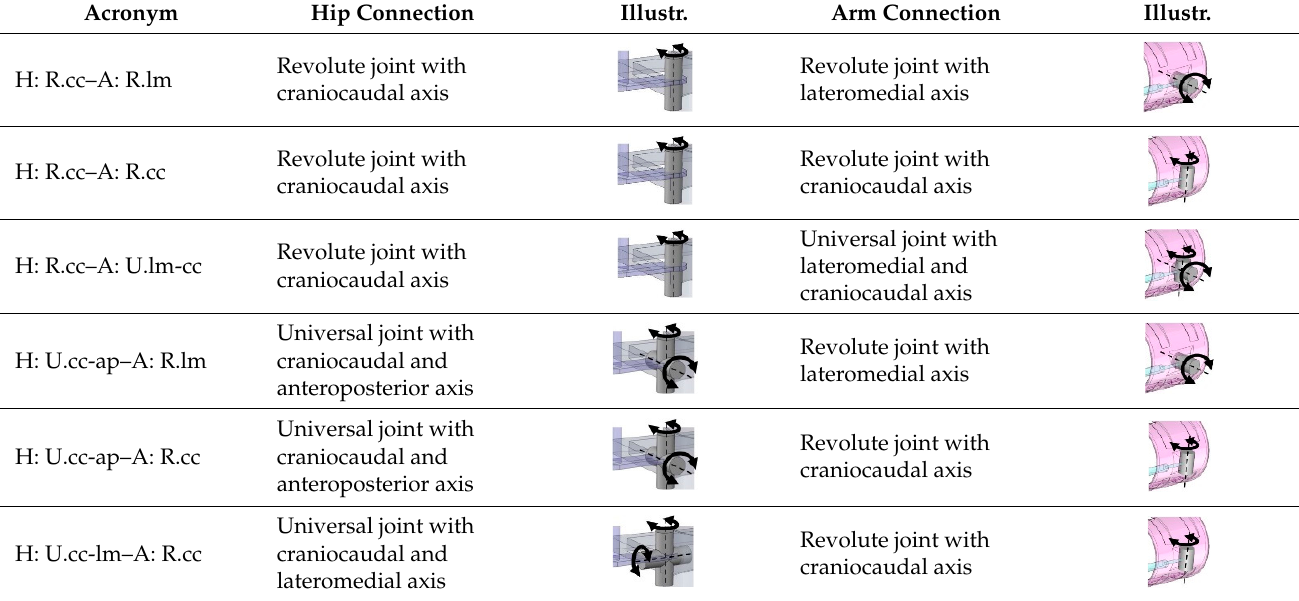
Table 2. Acronyms for different joint combinations. The names of the rotational axes of the joints correspond to anatomical terms of direction when the wearer is standing upright with both shoulders flexed (90 ◦ , 0 ◦ abduction). The abbreviation of those axes is reflected in the acronym. An illustration of the joint combination (left: hip belt, right: arm bracing) is presented in the corresponding columns.